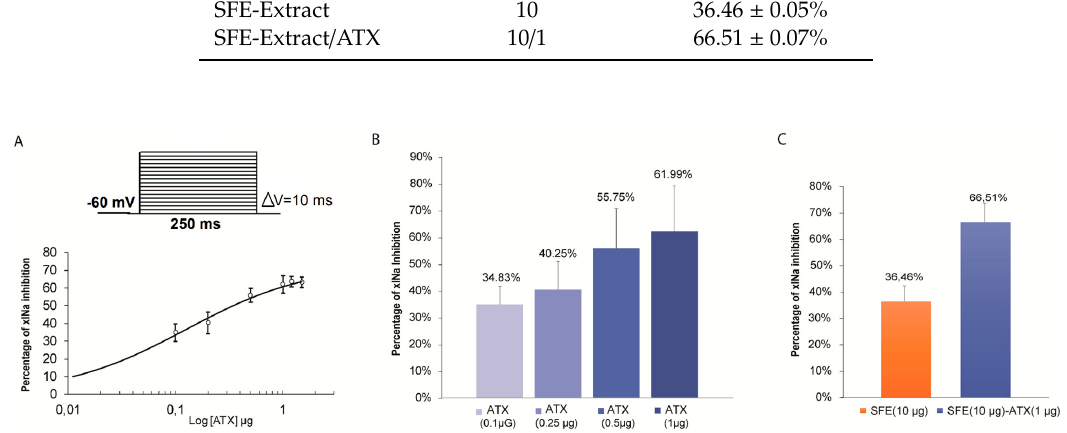
Figure 5. Analysis of ATX and SFE-Extract inhibitory e ff ects on amiloride-sensitive sodium currents in Xenopus oocytes. In ( A ) Doses-response curve for the M1 inhibitory e ff ect on Xenopus endogenous currenttracesrecordedduringa250msvoltageclampstepat60mVfromaHPof − 60mV.( B